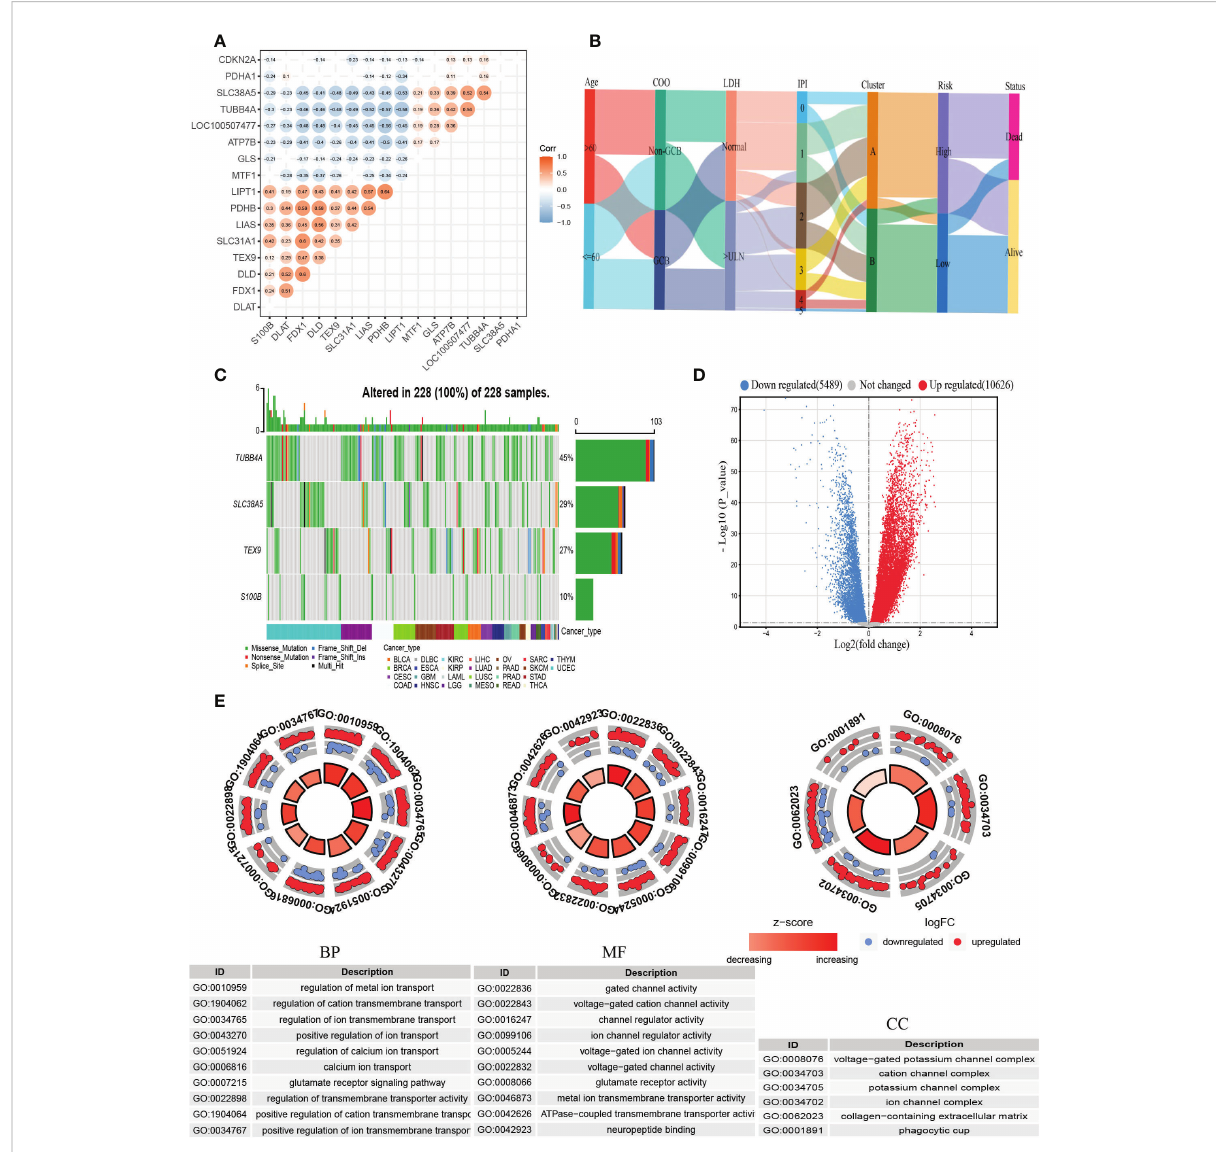
FIGURE 6 Comprehensive analysis of the cuproptosis-related prognostic model. (A) Correlations between CRGs and the prognostic model. The results of P >0.05 were not shown. (B) Alluvial diagram showing clinical characteristics distribution and survival differences of CRG clusters and risk groups. (C) The tumor mutation burden frequency of genes in the prognostic model in the pan-cancer analysis. (D) The DEGs between high- and low- risk groups. (E) GO enrichment analyses of DEGs. COO, cell of origin; LDH, lactate dehydrogenases; IPI, International Prognostic Index; DEGs, differentially expressed genes; GO, Gene Ontology; BP, biological process; CC, cellular component; MF, molecular